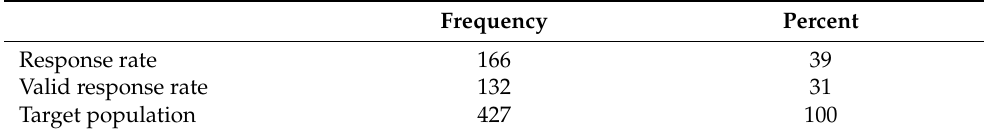
Table 1. Survey response rate.